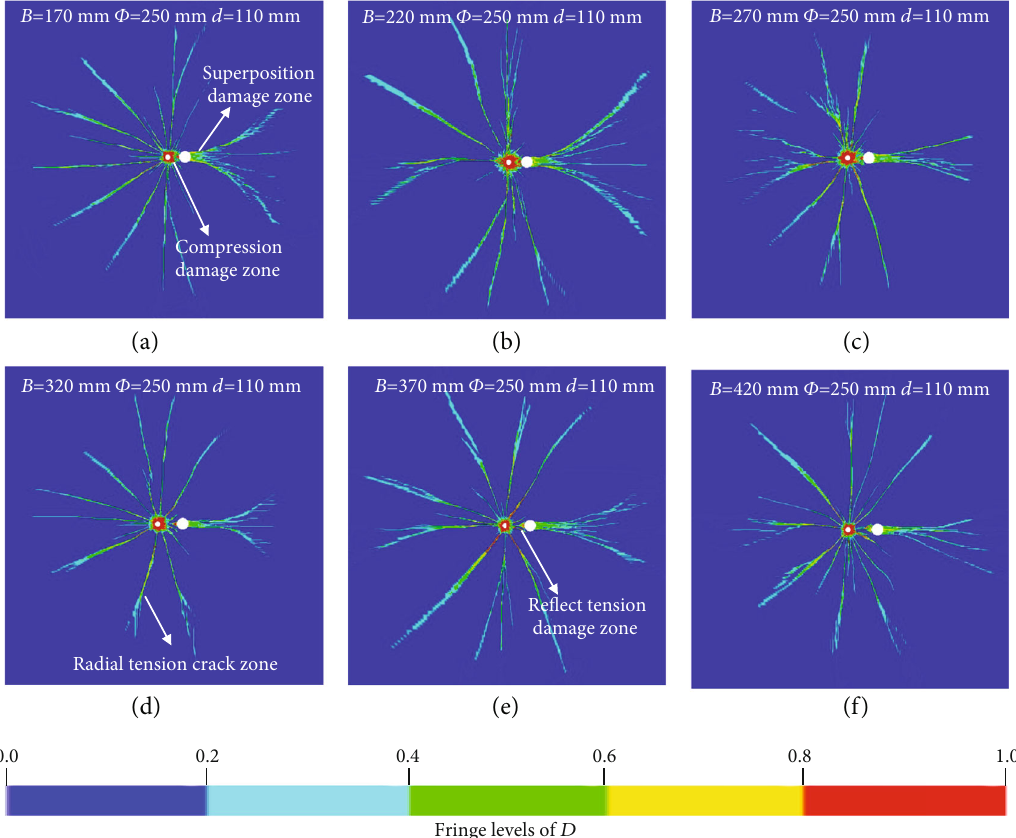
Figure 3: Overall damage of prime cut blasting under di ff erent burdens: (a) scheme 1, (b) scheme 2, (c) scheme 3, (d) scheme 4, (e) scheme 5, and (f) scheme